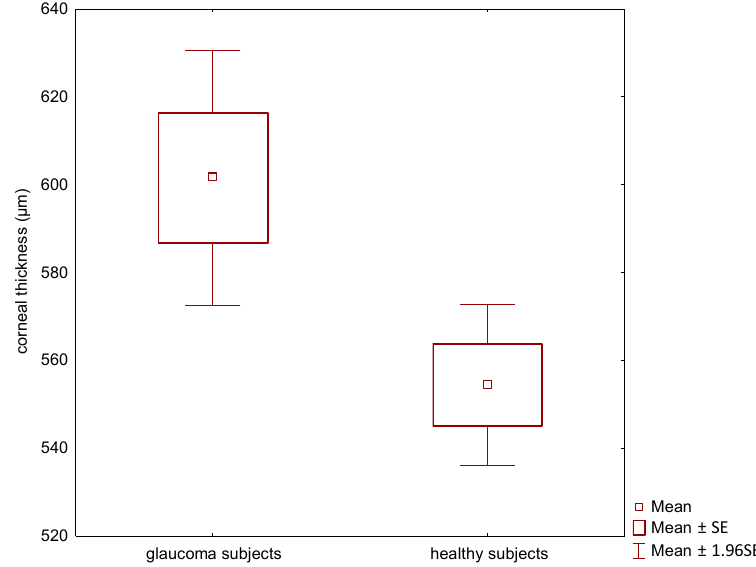
Figure 2. Corneal thickness for glaucoma vs. healthy subjects in the form of box plots.